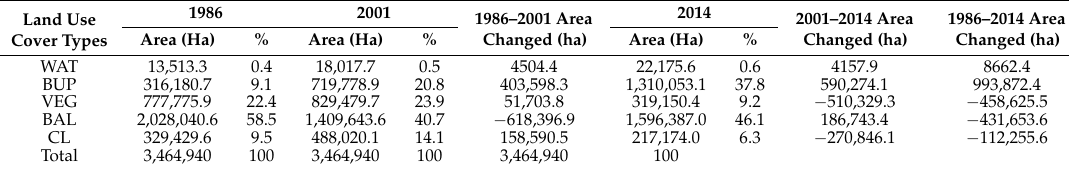
Table 10. Spatial analysis result of error adjusted matrices of the 1986, 2001 and 2014 LULC maps from showing map category, class area in hectares and percentage and area changed in hectares.